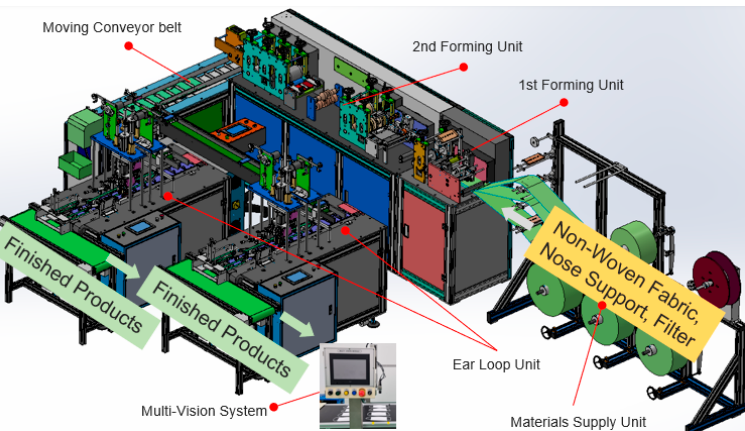
Figure 1. Mask production line with a multi-visual inspection system in mask manufacturing factory.